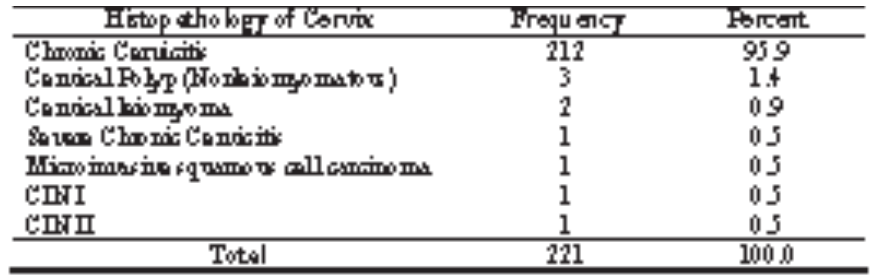
Table IV: Histopathology of cervix